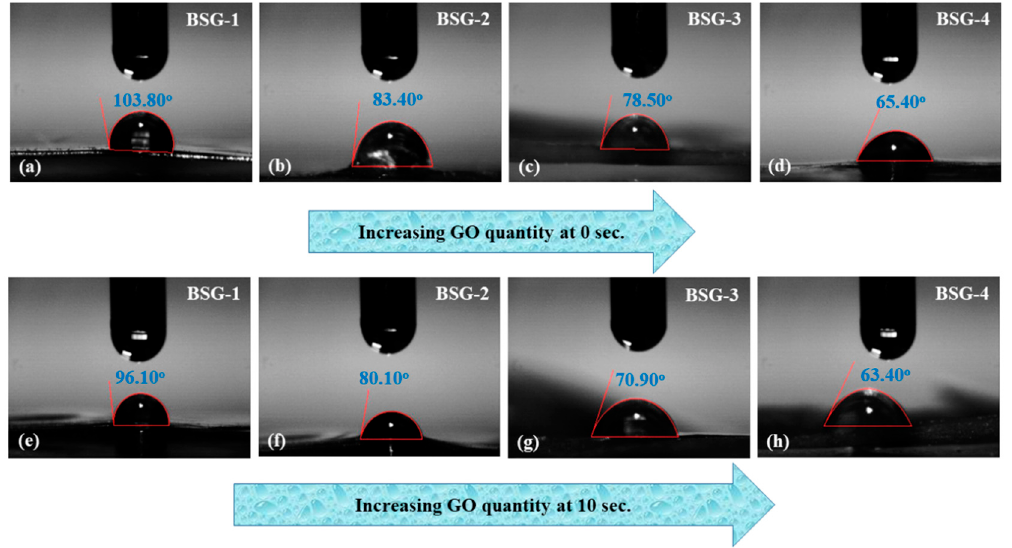
Figure 3. The wetting analysis of the hydrogel was conducted via water contact angle to determine the hydrophilicity and hydrophobicity nature of the hydrogels. The wetting behavior was investigated at different time intervals and 4( a – d ) wetting behavior at 0 s while 4( e – h ) wetting behavior of hydrogels at 10 s.